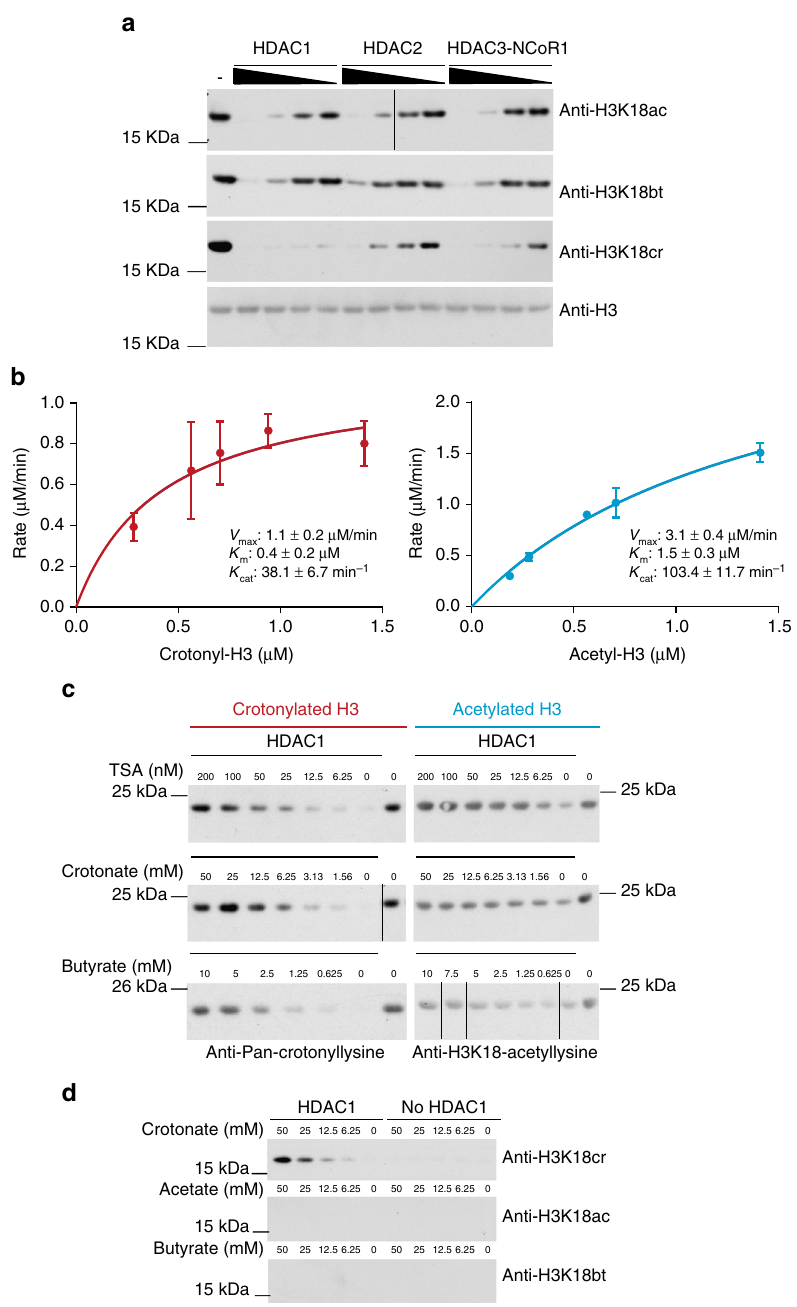
Fig. 7 Class I HDACs are histone decrotonylases. a Histone H3 decrotonylation and deacetylation in vitro by HDAC1, HDAC2, or HDAC3/Ncor1 complex; 5.65 μ M histones were crotonylated or acetylated in vitro and then subjected to removal of the modi fi cation by the indicated HDACs. HDAC1 was 0.25, 0.12, 0.06, and 0.03 μ M. HDAC2 was 0.18, 0.09, 0.05, and 0.02 μ M. HDAC3/Ncor1 complex was 0.45, 0.23, 0.11, and 0.06 μ M. b Comparative kinetics of HDAC1 decrotonylation and deacetylation; 5.65 µ M histones were crotonylated or acetylated and then subjected to removal of the modi fi cation by 0.03 µ M HDAC1 for different lengths of time. Samples were analyzed by dot blotting and initial rates of reaction were determined by plotting substrate removal over time. Kinetic parameters V max , K m , and K cat , error bars are SEM, n = 3. c Effect of HDAC inhibitors TSA, crotonate, and butyrate on deacetylation and decrotonylation by HDAC1 in vitro. Representative blots of two repeat experiments are shown. d Histone crotonylation by HDAC1 using crotonate in vitro. Incubation of crotonate, acetate, or butyrate with or without HDAC1 followed by western blotting analysis with anti-H3K18ac/bt/cr. Western blot of HDAC1 and crotonate assay is representative of two western to manual inspection and validation using the viewer.exe module integrated in MQ dimethylation (+28.031 Da), trimethylation (+42.046 Da), acetylation (+42.010 software 47 . Extracted ion chromatograms were constructed for each precursor Da), and crotonylation (+68.074 Da). The use of high-accuracy criteria for HCD fragment ions tolerance (20 ppm) guarantee the capability to discriminate among based on the m / z value, using a mass tolerance of 10 ppm with a mass precision up other possible forms of acylation (e.g., lysine butyrylation (70.0418Da) and β - to four decimals. For each histone-modi fi ed peptide, the relative abundance per- hydroxybutyrylation (86.0367Da)), therefore they were not included in the search. centage (RA%) was estimated by dividing the area under the curve (AUC) of each MaxQuant search results were exported and peptides with Andromeda score < 60 modi fi ed peptide over the sum of the areas corresponding to all observed isoforms and localization probability score < 0.75 were removed. Filtered data were subjected of that peptide, including the unmodi fi ed forms 48 . Signi fi cant changes among crypt